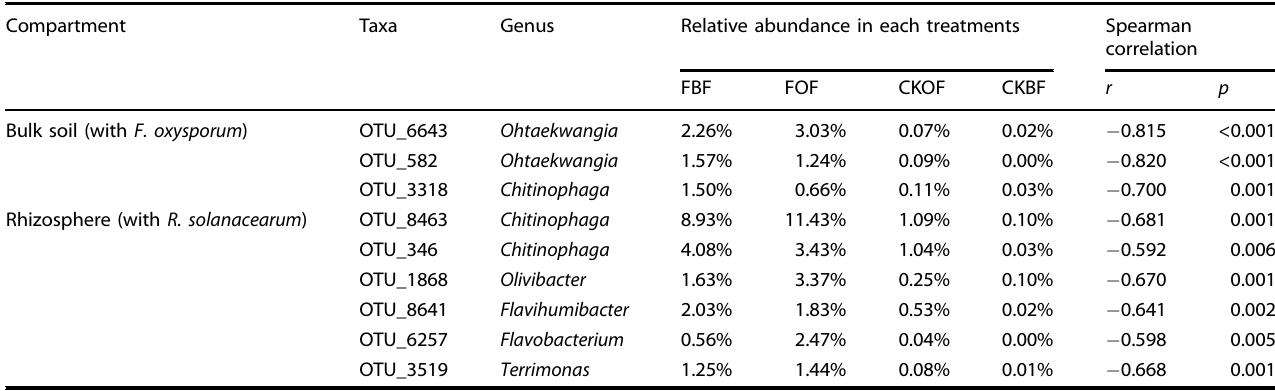
Table 2. Spearman correlation between bacterial OTUs and pathogens. Compartment Taxa Genus Relative abundance in each treatments Spearman